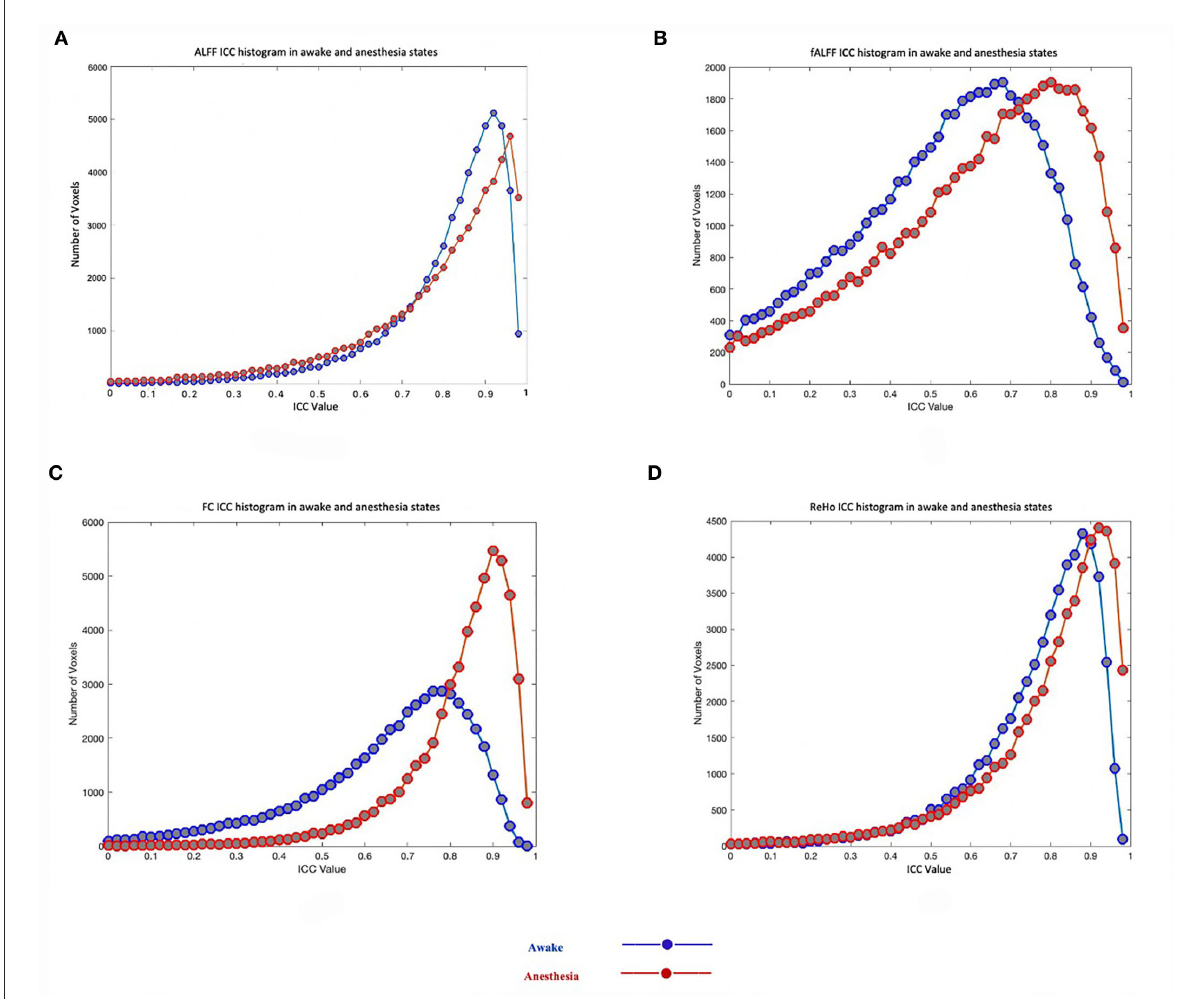
FIGURE2 Test–retest reliability (ICC) histograms of rs-fMRI metrics including the amplitude of low-frequency fluctuation (ALFF) (A) , fractional amplitude of low-frequency fluctuation (fALFF) (B) , functional connectivity (FC) (C) , and regional homogeneity (ReHo) (D) in two states of awake and under